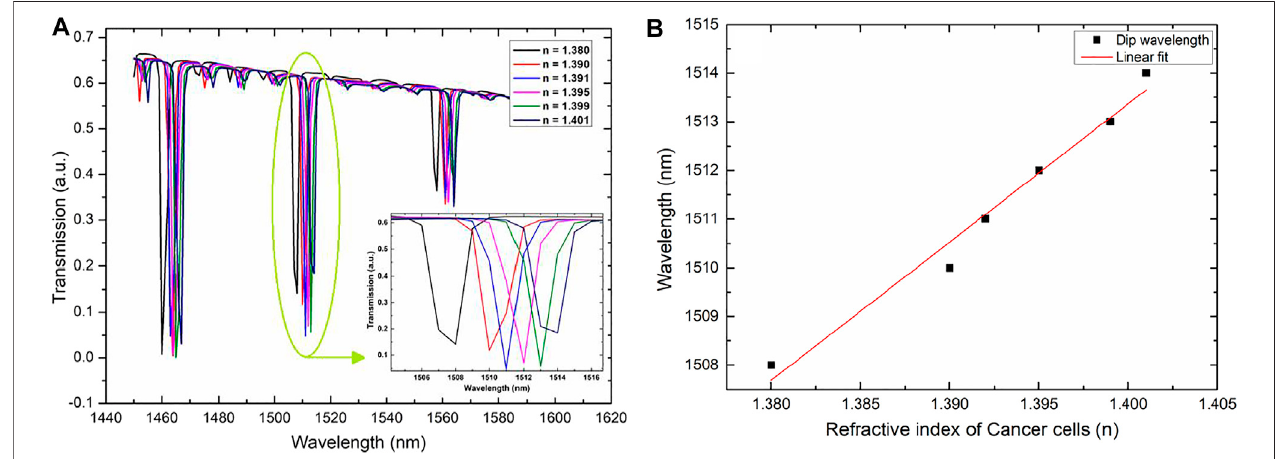
FIGURE7|(A) Transmissionspectraofthesensorwith55%porosityatdifferentrefractiveindexesofcancercellsvaryingfrom1.380to1.401.Theinsetshowsan enlarged view of the transmission spectrum near the 1,510 nm wavelength. (B) Variations in the dip wavelength at different refractive indexes near 1,550 nm.